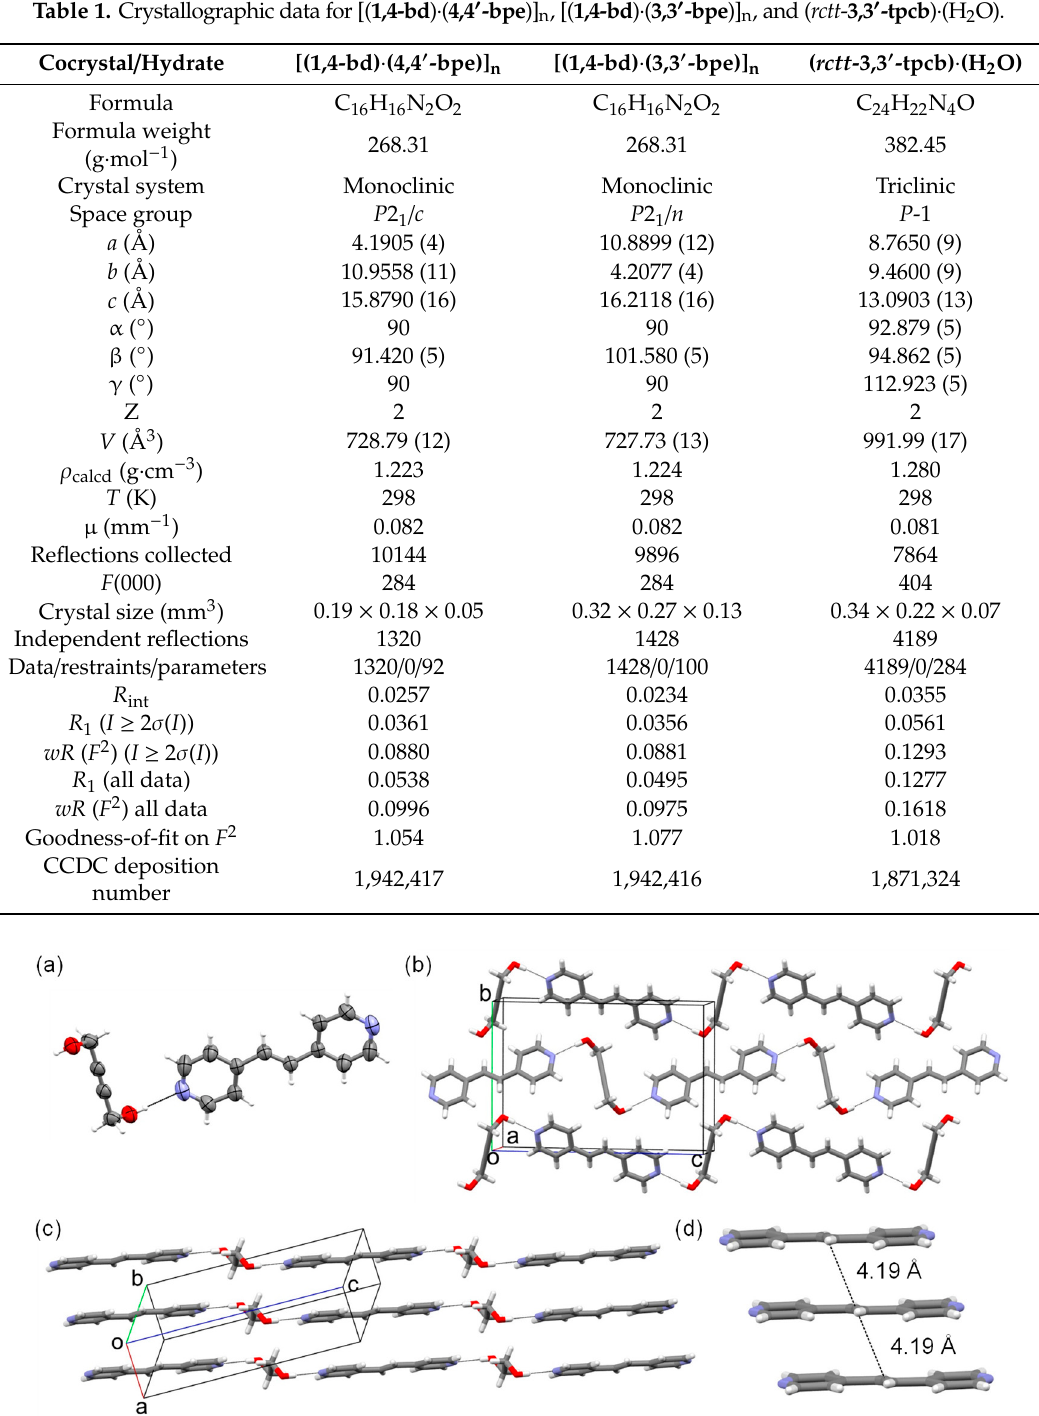
lamp) for a period of 55 h. A 1 H-NMR spectrum revealed the emergence of a single cyclobutane resonance (4.68 ppm) consistent with rctt -tetrakis (4-pyridyl) cyclobutane ( 4,4-tpcb ) (79% conversion), which was accompanied by a decrease in intensity of the olefinic signals (see Figure S2).